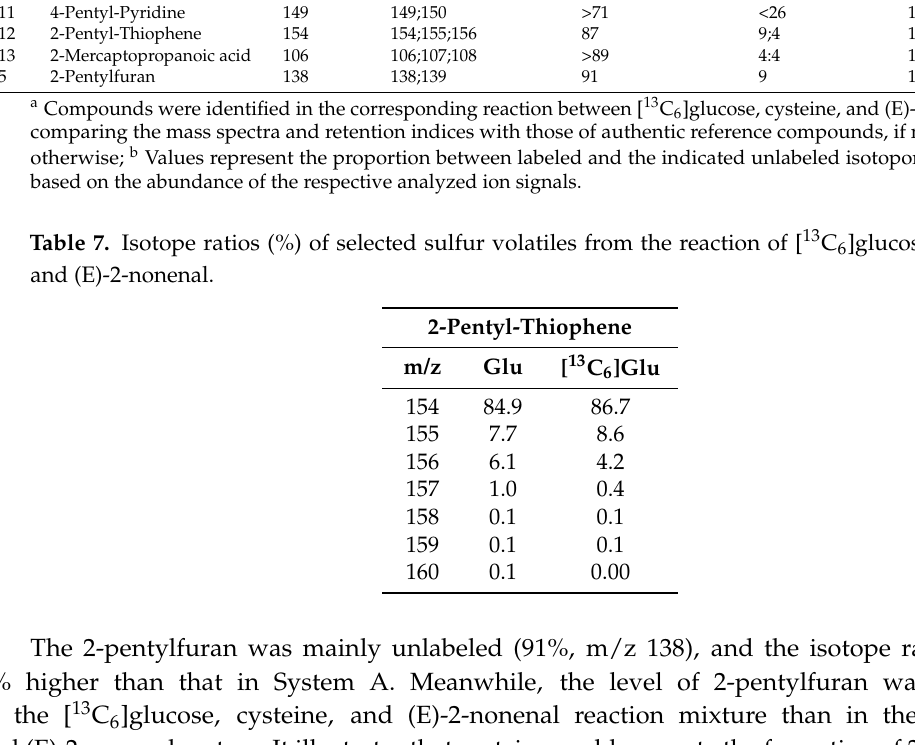
Table 6. Proportion of isotopomers formed from [ 13 C 6 ]glucose, cysteine, and (E)-2-nonenal. No. Compound a